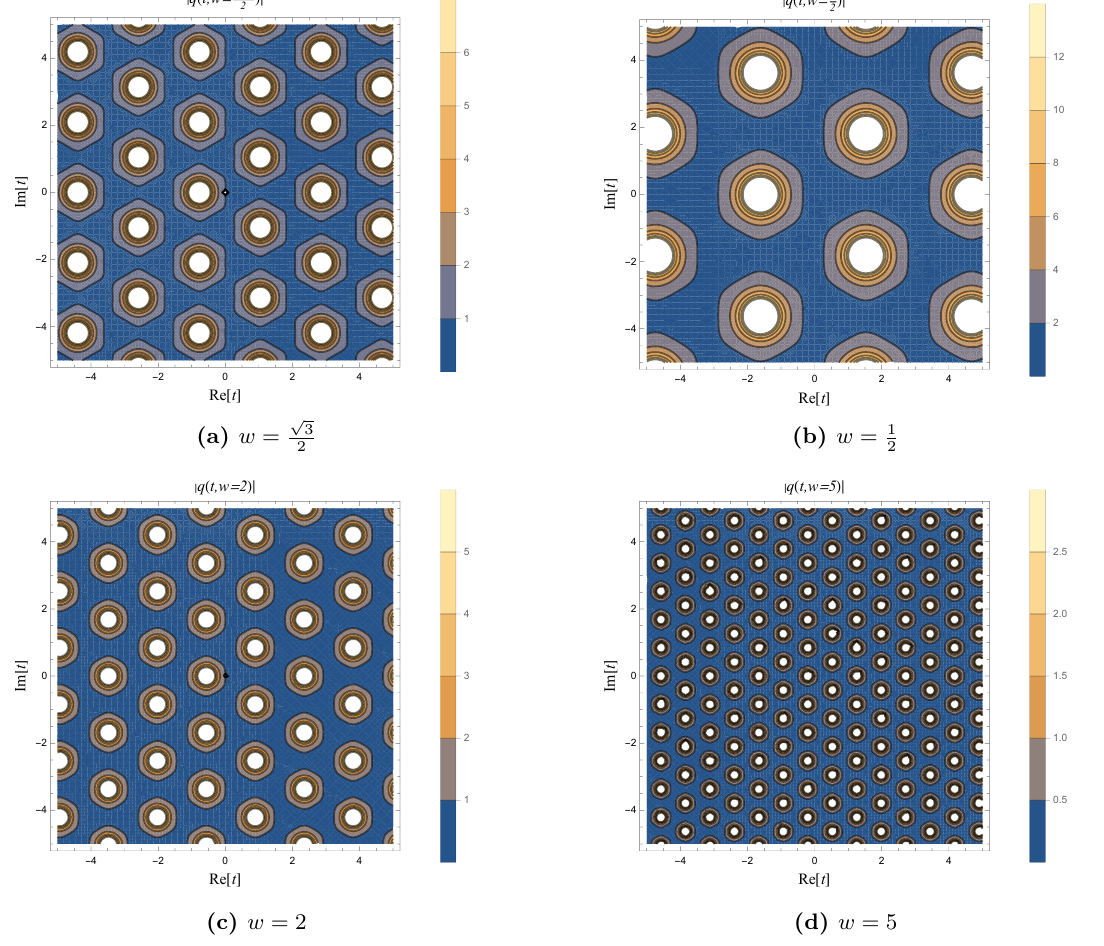
Figure 1. The function | q ( t, w ) | in the case N = 1 is plotted for different values of w . It can be seen that it exhibits a double periodic pole structure, where the distance between the poles is controlled by the variable w